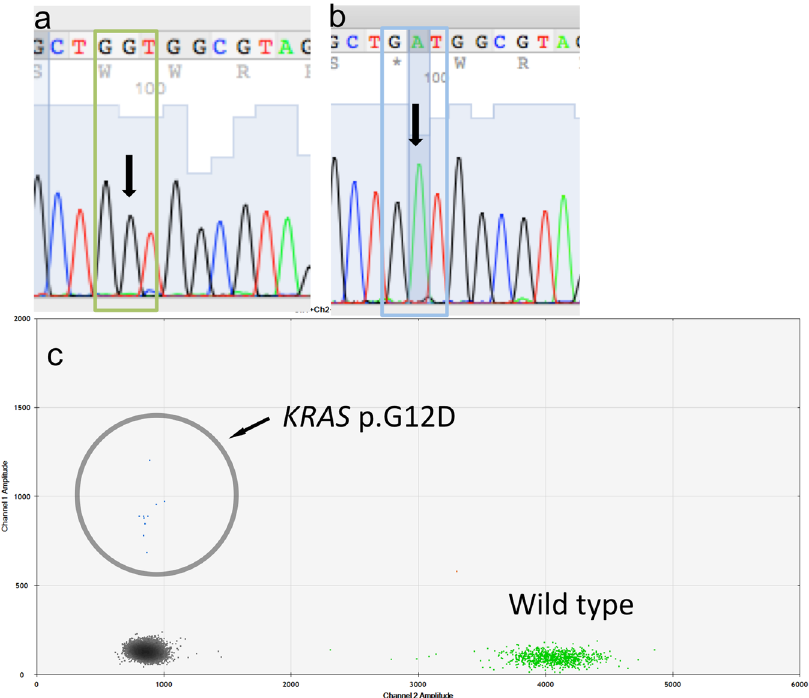
Figure 3. ( a ) Example Chromatogram (antisense strand) wild-type KRAS in a negative control sample. ( b ) Example Chromatogram (antisense strand) KRAS c.35G > A (pG12D) in a CTC sample. ( c ) Example ddPCR result (Patient 45) for KRAS G12D. The number of events is very low which represents a very low copy of mutant KRAS G12D molecules in the specimen. The circle encircles the area of interest and the approximately 6